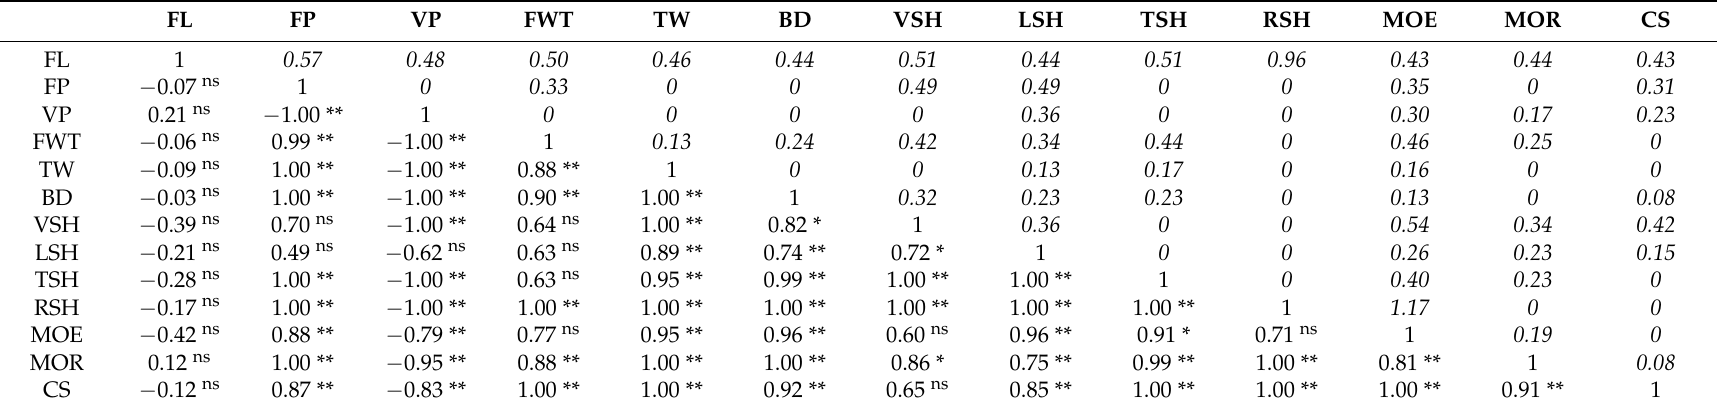
Table 6. Estimated genotypic correlations (below diagonal) and standard errors (above diagonal, in Italic ) for the anatomical, physical, and mechanical properties of hybrid poplar